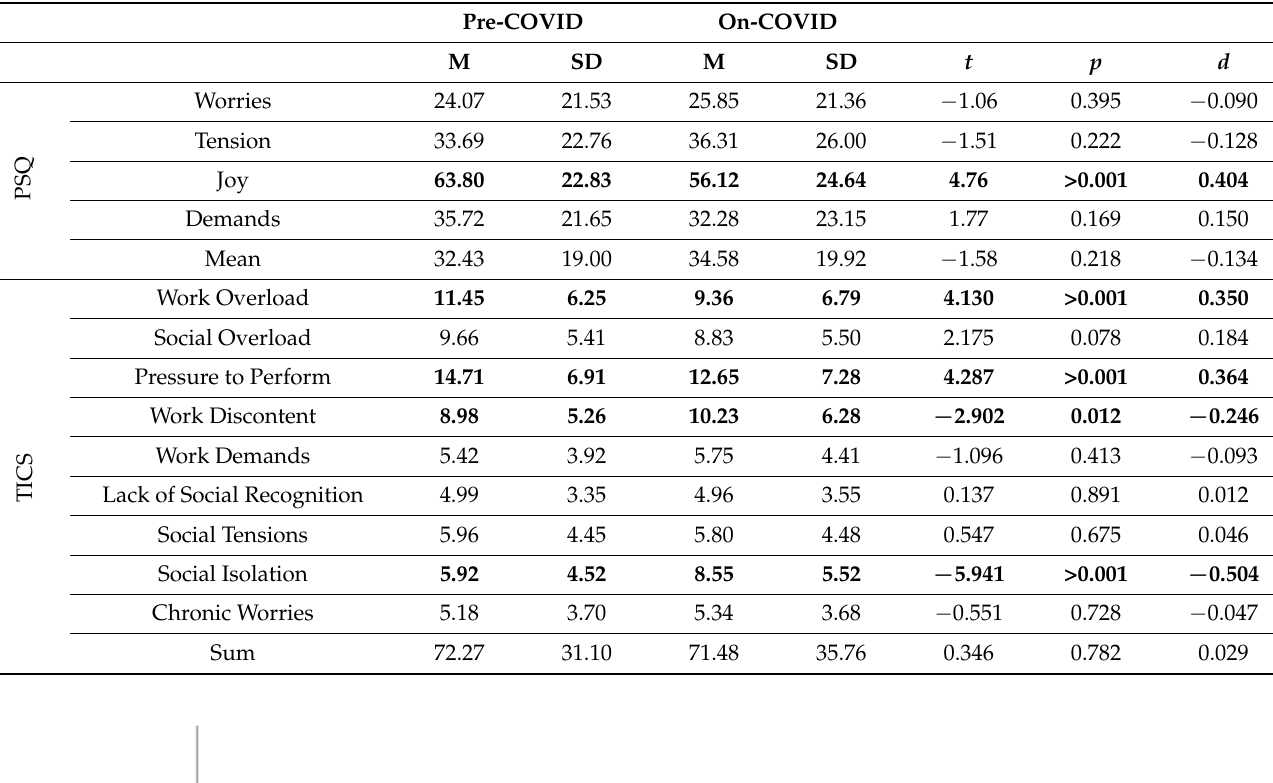
Table 1. Means (M) and standard deviations (SD) of PSQ and TICS stress subscales for pre-COVID vs. on-COVID measurements and results of paired t -tests ( n = 139) with Cohen’s d as effect sizes. All p -values are corrected for false discovery rate (FDR; [39]), significant differences are printed in bold.